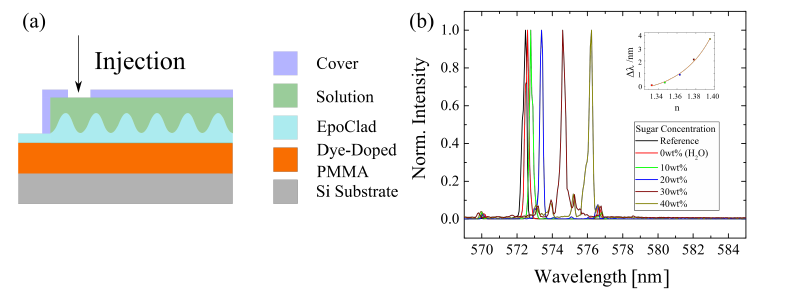
Figure 6. ( a ) The sample model was modified to detect the solution with different sugar concentration. ( b ) The lasing spectra under the influence of different sugar concentration were